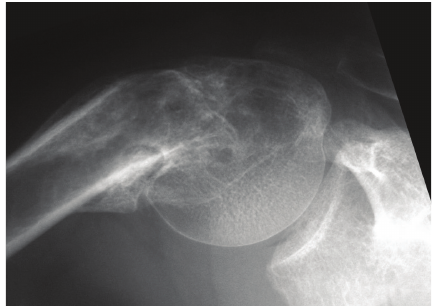
Figure 3: In fluoroscopic dynamic observation, greater tuberosity smoothly passes under the acromion without causing impingement; however, it does come into contact with the upper glenoid rim, which seems to block further glenohumeral abduction.